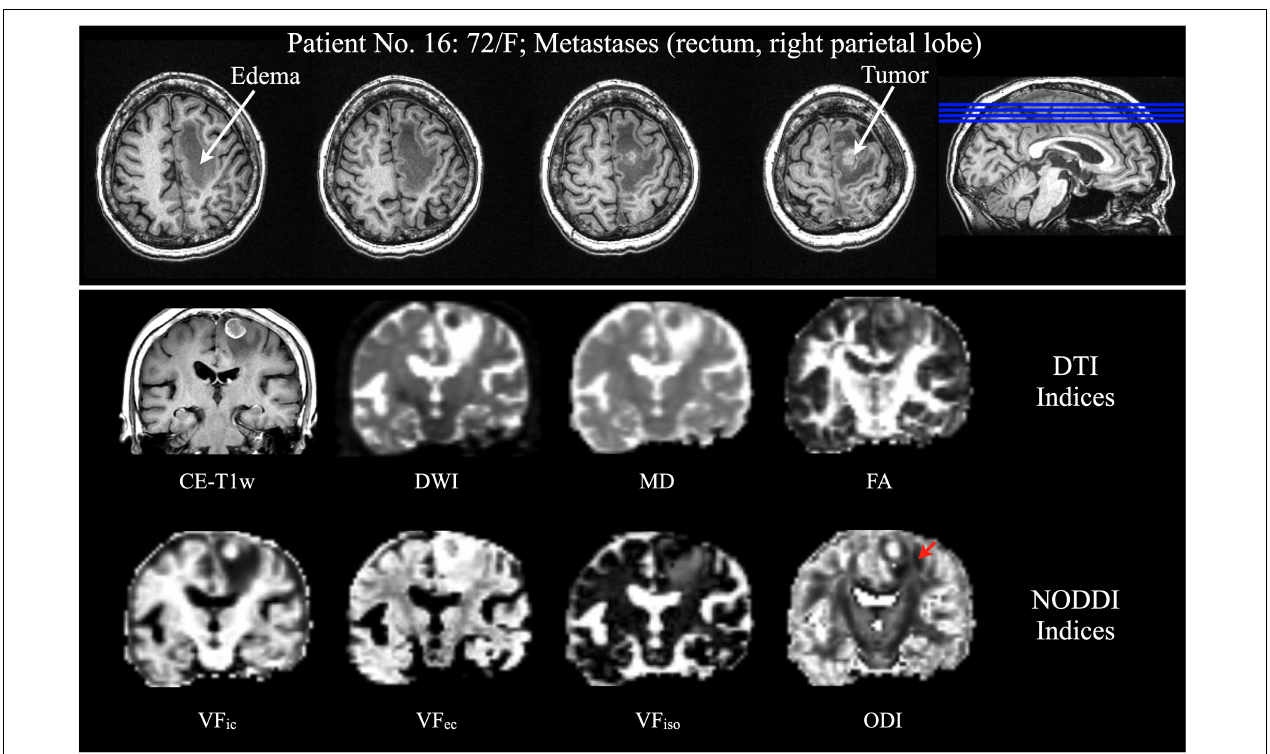
FIGURE 2 | Patient No. 16, a 72-year-old woman with rectum metastasis in the right parietal lobe. (Top) Axial view of CE-T1WI displays an enhancing tumor in the right superior frontal lobe, with significant vasogenic edema. (Bottom) Coronal view of CE-T1WI, DWI, DTI indices (MD, and FA), and NODDI indices (VF ic , VF ec , and VF iso ) could not reveal the CST except the ODI from NODDI (red arrow). CE-T1WI, contrast enhanced T1-weighted images; DWI, diffusion-weighted imaging; DTI, diffusion tensor imaging; MD, mean diffusivity; FA, fractional anisotropy; NODDI, neurite orientation dispersion and density imaging; VF ic , intracellular volume fraction; VF ec , extracellular volume fraction; and VF iso , isotropic volume fraction; CST, corticospinal tract; and ODI, orientation dispersion